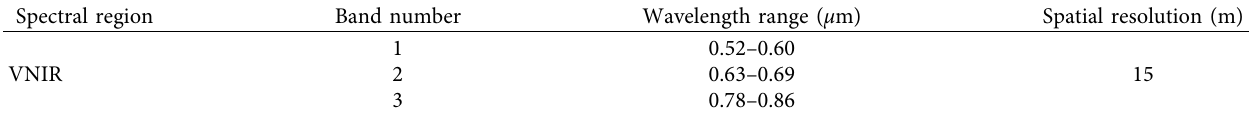
Table 1: Wavelength ranges and spatial resolution of ASTER